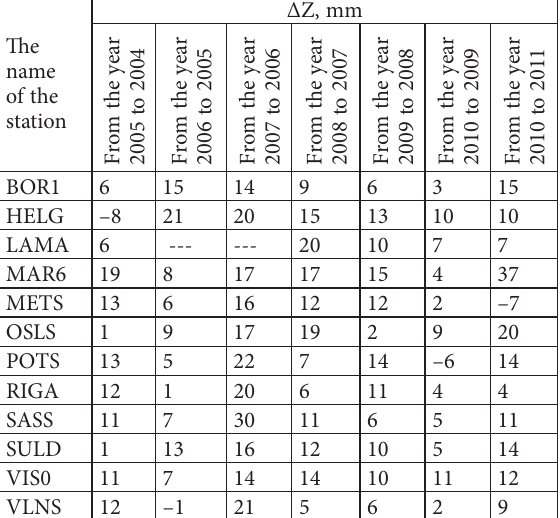
Table 3. The displacements of geocentric coordinate Z of the EUREF GPS network